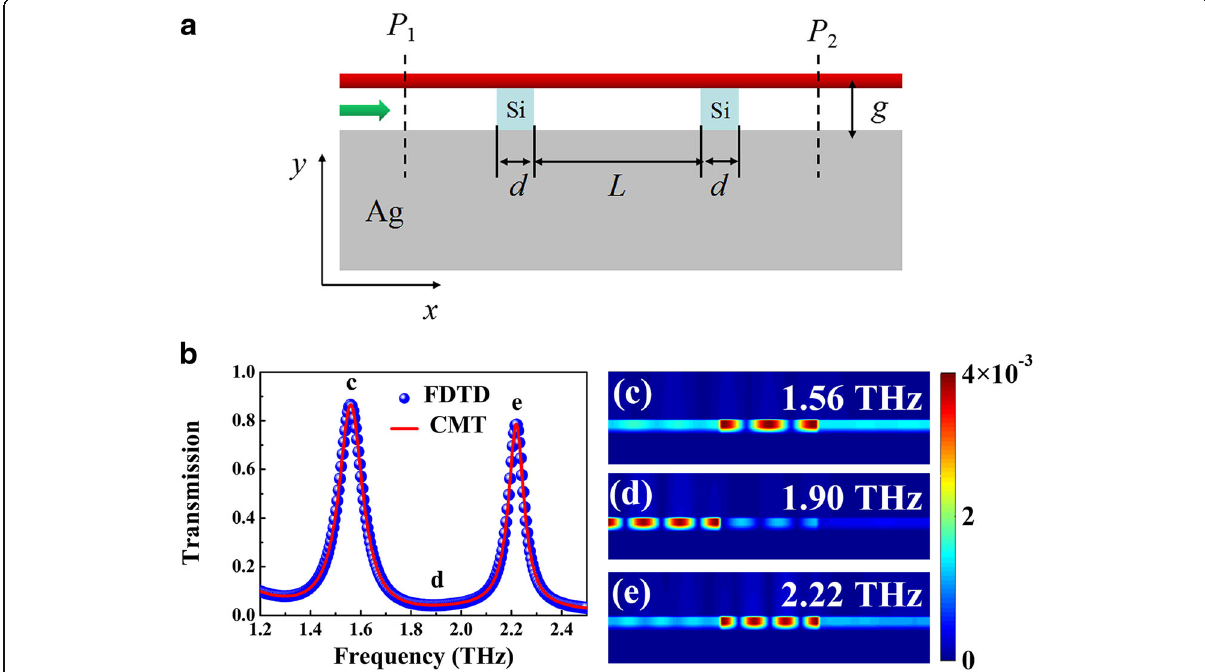
Fig. 4 a Schematic of the BIM waveguide with introduced silicon ribbons. The width of each silicon ribbon is d , and the distance between the ribbons is L . b Numerical (blue balls) and CMT fitted (red curve) transmission spectra of the proposed structure where g = 1 μ m, d = 5 μ m, and L = 120 μ m. c – e Magnetic field distributions (| H z | 2 ) of at the incident frequencies of 1.56 ( c ), 1.90 ( d ), and 2.22 THz ( e